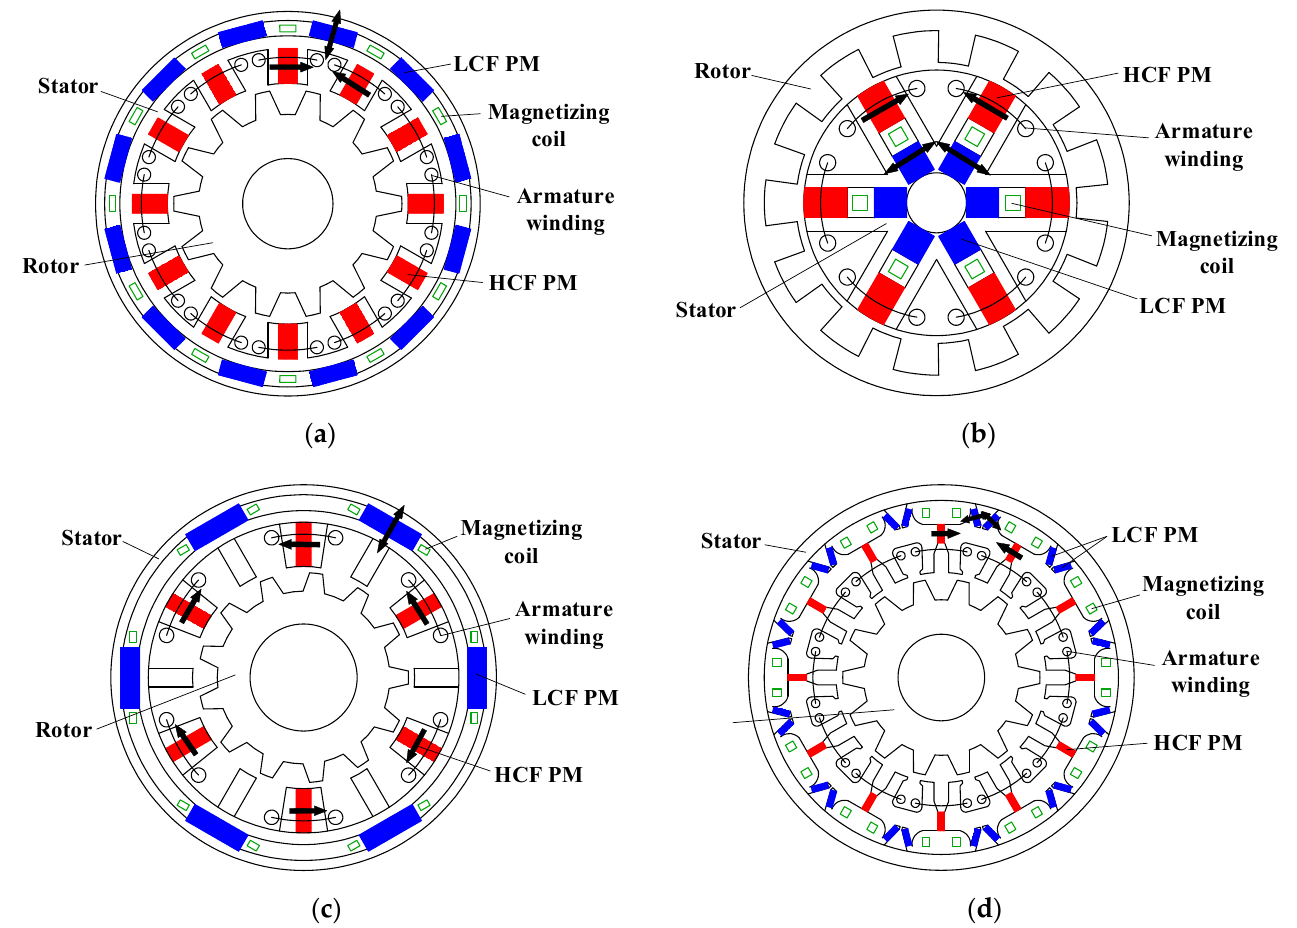
Figure 40. Various hybrid PM VFM machines based on switched ‐ flux topology. ( a ) U ‐ core stator [103]. ( b ) Spoke ‐ type PMs [104]. ( c ) E ‐ core stator [105]. ( d ) V ‐ type LCF PM [106].